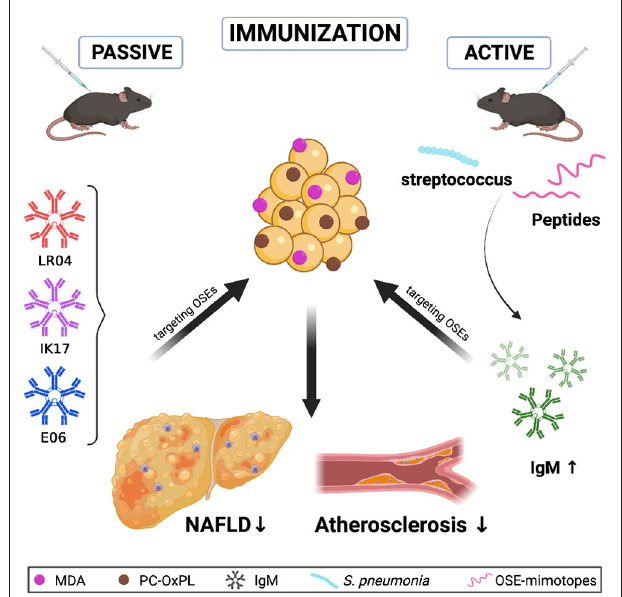
FIGURE 2 | In mice, passive immunization strategies with OSE-recognizing IgM antibodies LR04, IK17, and E06, or boosting IgM antibody titers toward oxidized lipids in active immunization approaches, such as with heat-inactivated S. pneumococci or specific peptides, can induce protection against NAFLD progression and reduce atherosclerotic plaque